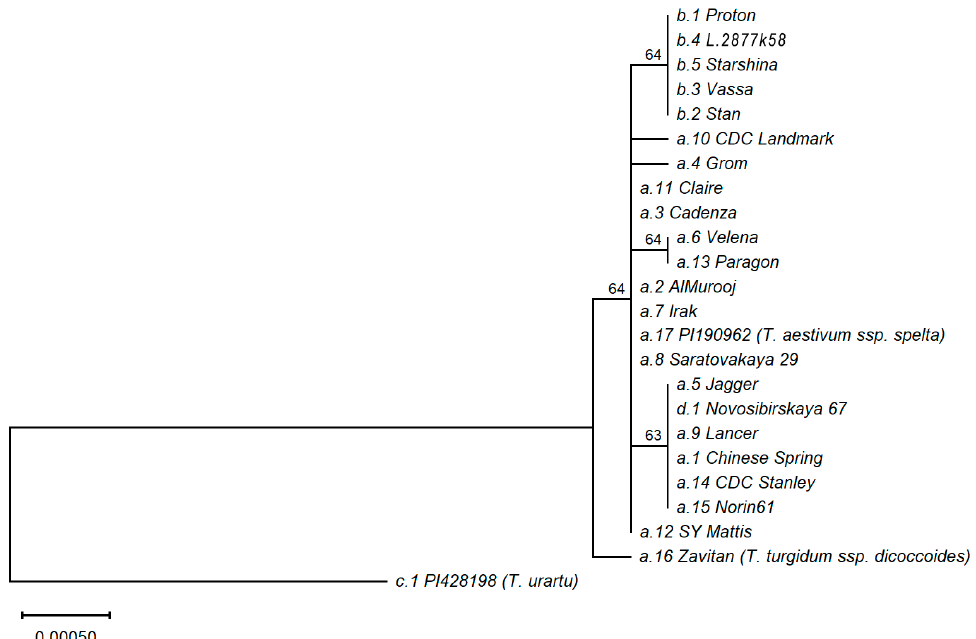
Figure 3. Molecular phylogenetic tree (subtree) of GRF3-2A haplotypes (gene + flanking sequences). To find a root, GRF3-2B gene of Chinese Spring was taken as an outgroup (not shown here). Bootstrap values are shown above nodes. At the tree leaves the Grf3-2A haplotypes and representative wheat accessions are indicated. If not specified, the accessions are Triticum aestivum L. ssp. aestivum .